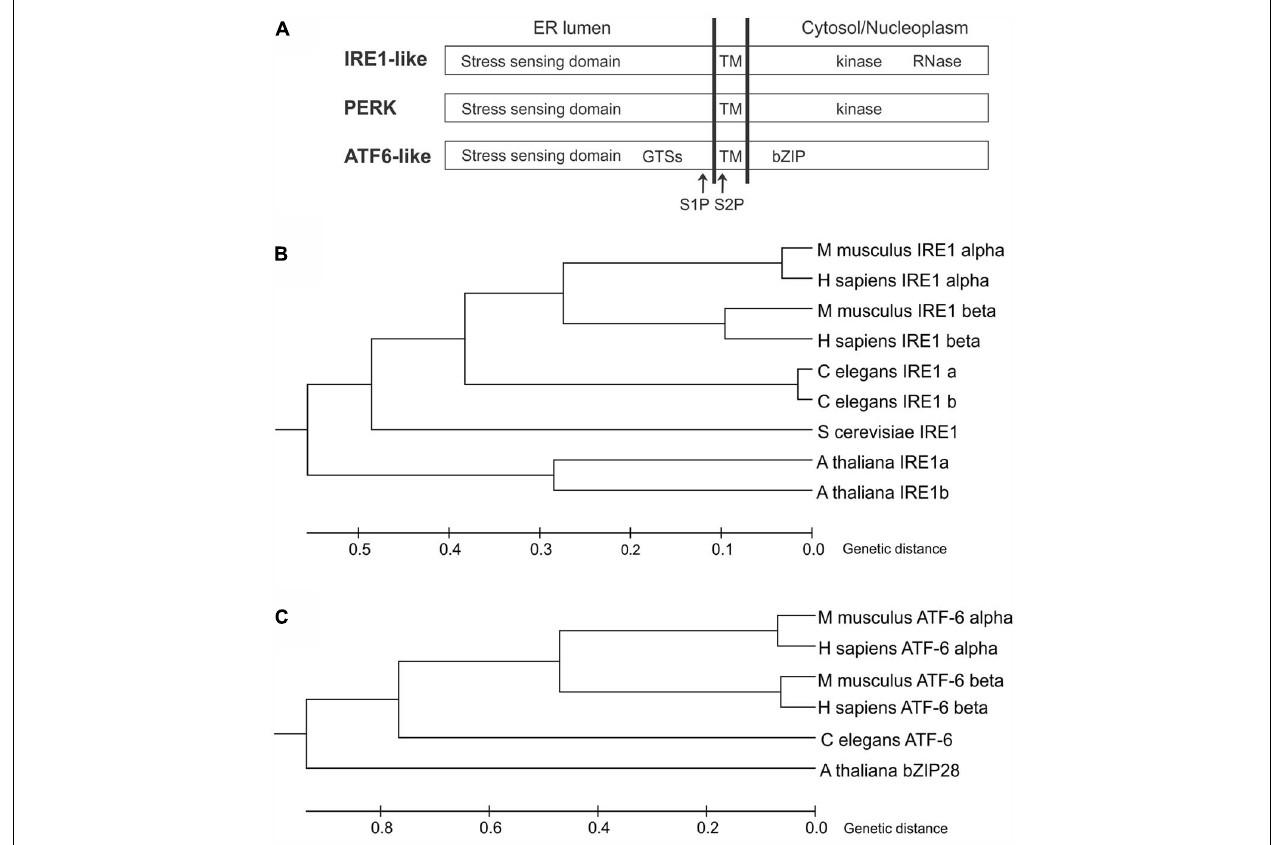
FIGURE 1 | ER stress-sensing proteins in eukaryotes. (A) Schematic diagram of IRE1-like, PERK and ATF6-like proteins (not to scale). GTSs, Golgi trafficking signals; TM, transmembrane domain; S1P, site 1 protease cleavage site; S2P, site 2 protease cleavage site; bZIP, basic leucine zipper domain. (B) Phylogenetic tree analysis of IRE1-like proteins from Animalia ( Homo sapiens , Mus musculus and Caenorhabditis elegans ), Fungi ( Saccharomyces cerevisiae ) and Plantae ( Arabidopsis thaliana ) was constructed by the Unweighted Pair Group Method with Arithmetic Mean (UPGMA) method using MEGA6 software. NCBI reference sequences: IRE1 alpha ( H.s )-NP_001424, IRE1 beta ( H.s )-NP_150296, IRE1 alpha ( M.m )-NP_076402, IRE1 beta ( M.m )-NP_036146, IRE1a ( C.e )-NP_001254135, IRE1b ( C.e )-NP_001254136, IRE1 ( S.c )-NP_011946, IRE1a ( A.t )-NP_565419, IRE1b ( A.t )-NP_568444.